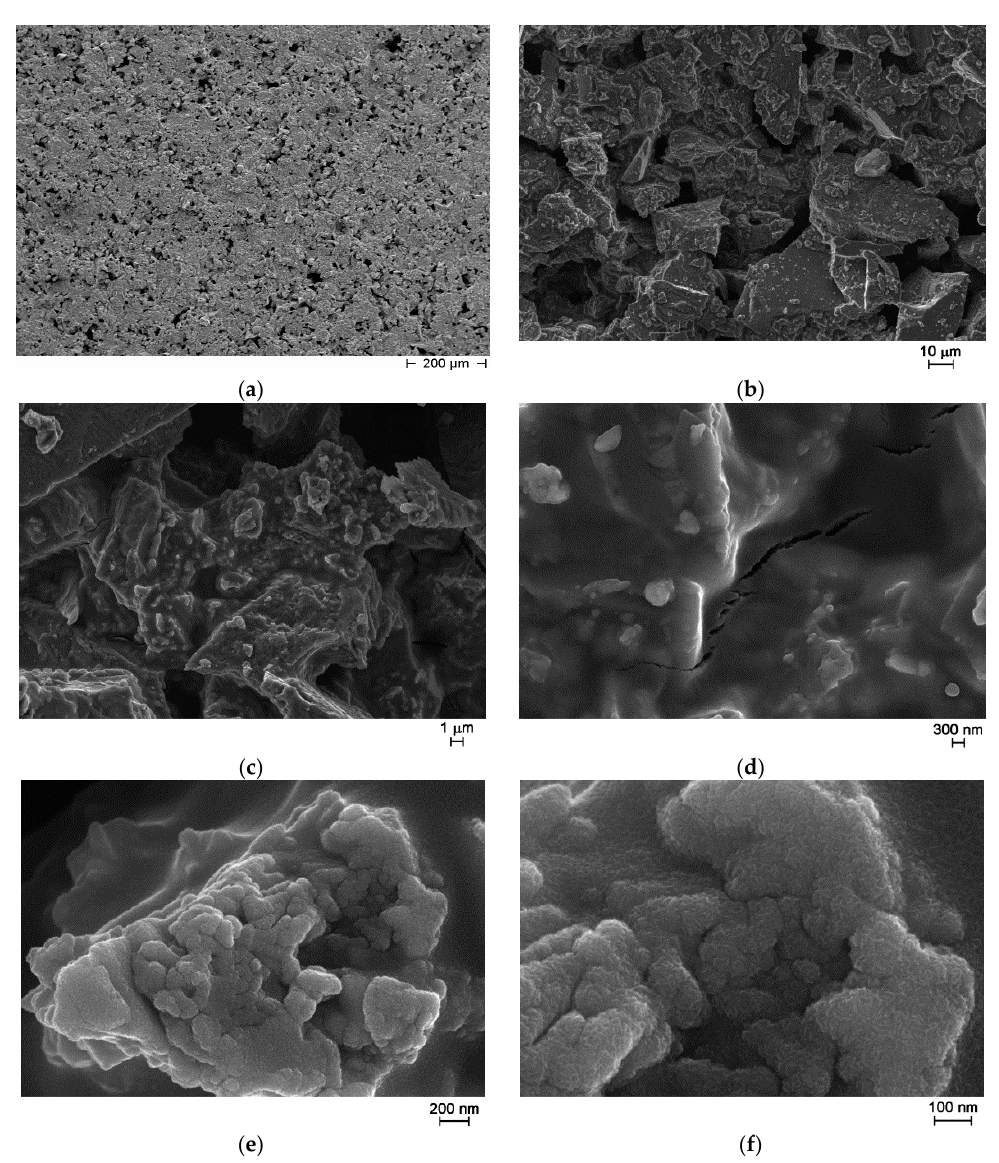
Figure 9. FE-SEM micrographs of sol-gel glass ceramic thick-film: pores in the screen-printed film ( a – c ); cracks ( d ); small particles due to sol-gel phase ( e ); ZnO crystals from sol-gel phase ( f ).